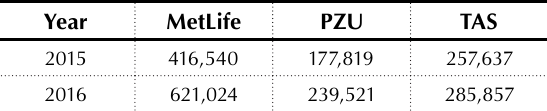
Table 7. Insurance premiums of life insurance